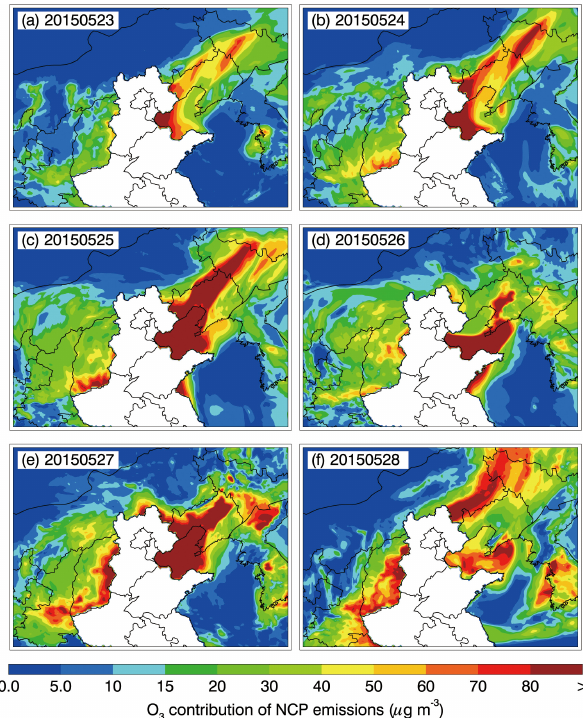
Figure 11. Same as Fig. 9, but for the afternoon (12:00–18:00BJT) O 3 concentration.